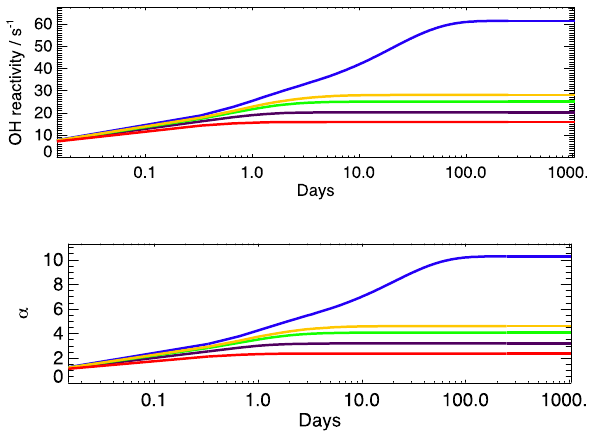
Figure 9: Evolution of total OH reactivity and α in the base simulation (dark blue) compared with simulations containing a rate of loss of all non-constrained species to physical processes equivalent to a lifetime of 12 h (red), 24 h (purple), 48 h (green) and 72 h (yellow). For a simple box, the physical loss of chemical species, whether from dilution into a lower background or the deposition of species to the surface or the canopy, or the formation of aerosol, can be considered to be a 1 st order loss process. For simplicity we give all unconstrained compounds the same physical loss lifetime. Figure 9 shows the impact of physical lifetimes of 12, 24, 48 or 72 h (the range is based on studies of deposition of oxygenated VOCs to forest canopies, Hall et al., 1999;Karl et al., 2004). This significantly reduces the reactivity of the system as isoprene degradation compounds are physically removed before they can impact the OH reactivity, either directly or through the production of further oxidation products. As the physical loss rate increases the oxidation products are increasingly rapidly removed from the system and the alpha of the system tends to 1, which is the value of the reactivity for isoprene alone. The timescale to reach steady state is significantly reduced by the introduction of this physical loss. The time to generate 75% of the steady state oxidation product reactivity (i.e. 50% of the steady state reactivity not including the reactivity due to reaction with isoprene itself) is over 20 days without physical loss but this becomes 12 h with a 72 h lifetime and less than 8 h for the 12 h lifetime case.